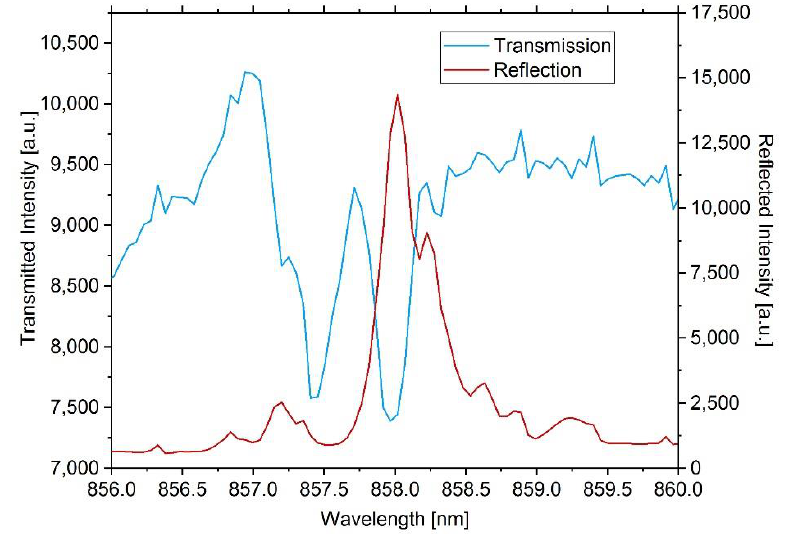
Figure 2. Transmission spectrum of the Bragg grating in free space optical arrangement and reflection spectrum after fiber coupling. The grating of the inscribed sensor reflects approximately 22% of the light coupled into the polymer waveguide. The right shoulder of the reflected Bragg peak probably results from variations of the refractive index modulations of the inscribed grating points and the grating period due to which two narrow Bragg resonance wavelengths can be seen. Two clear dips in the transmitted spectrum indicate losses due to other modes.